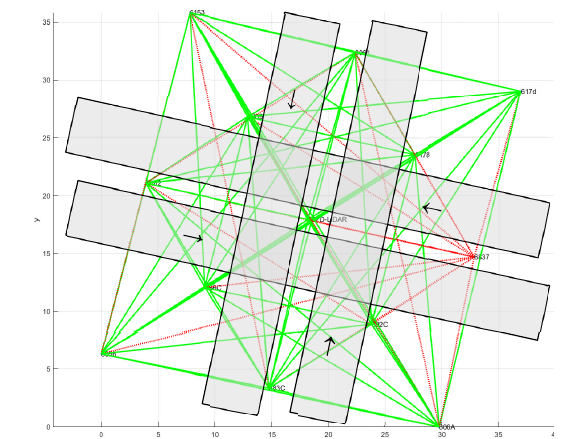
Figure 3 . Ground control network deployed at the simulated intersection area